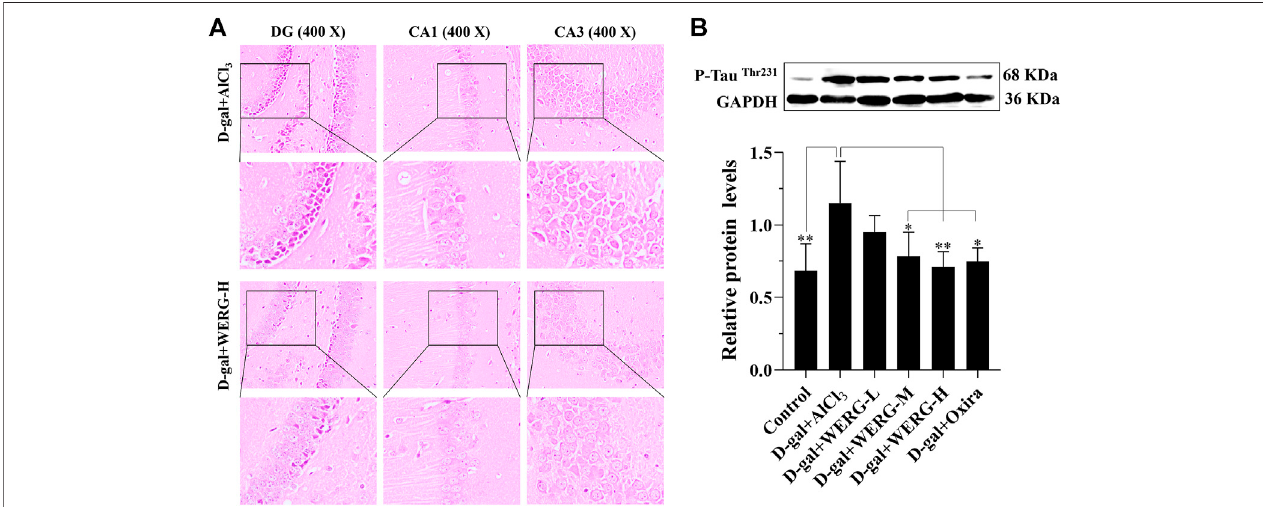
FIGURE 2 | WERG decreased hippocampus neuron damage in an AD mouse model. Pathological changes in the hippocampus CA1, CA3, and DG regions were detected by HE staining (400 ×) (A) ; the expression of p-TauThr231 was quantitatively analyzed by Western blotting (B) . Data were presented as mean ± SD repeated three times. “ * ” presented signi fi cant difference at p < 0.05 levels, “ ** ” presented signi fi cant difference at p < 0.01